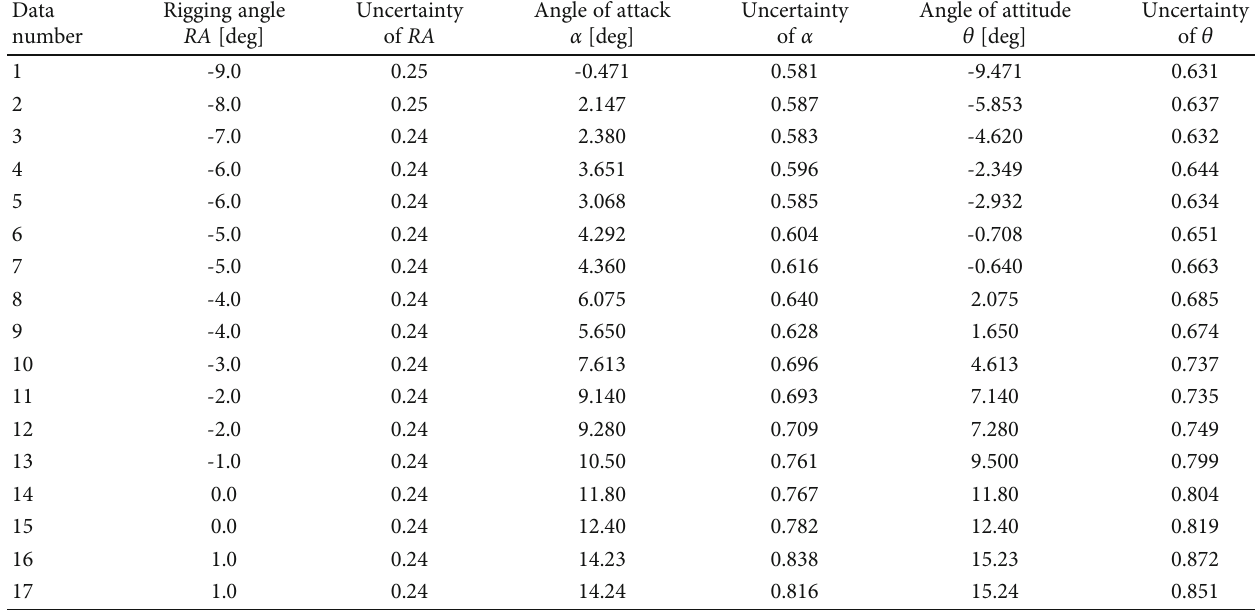
Table 7: Wind tunnel test result of 60Pa wind condition.